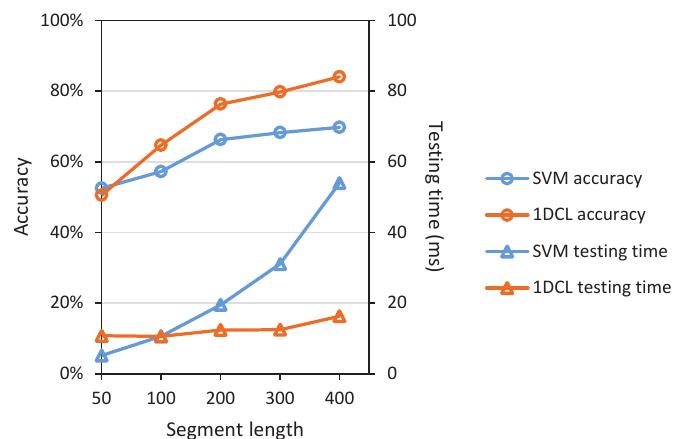
Figure 8. Accuracy and testing time of different approaches at varying vibration signal segment